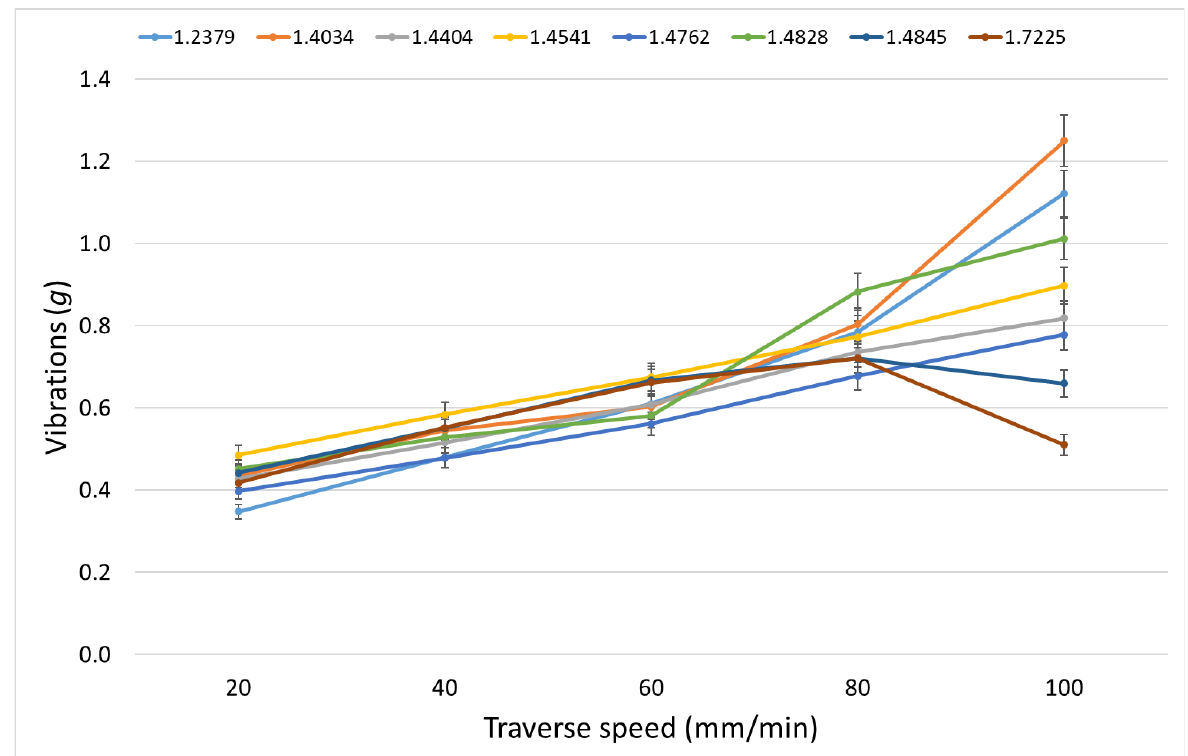
Figure 9. Vibrations in the x -axis on selected steels for tested traverse speeds.